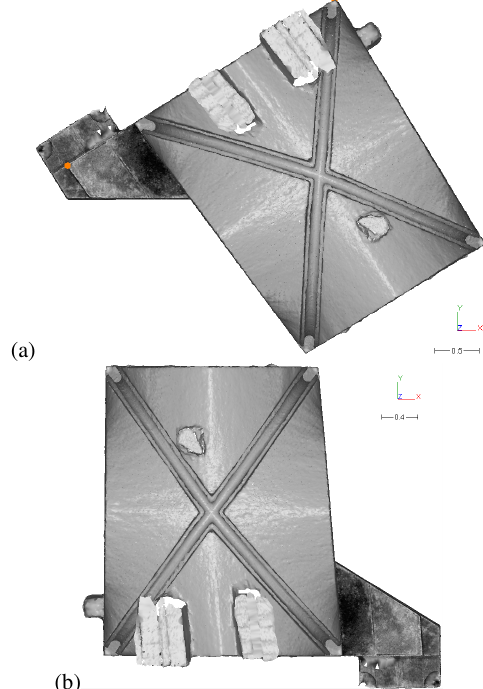
Figure 9. Vaulted 3D model: a) raw (used tie points in red); b) registered and aligned 3D model along the X axis